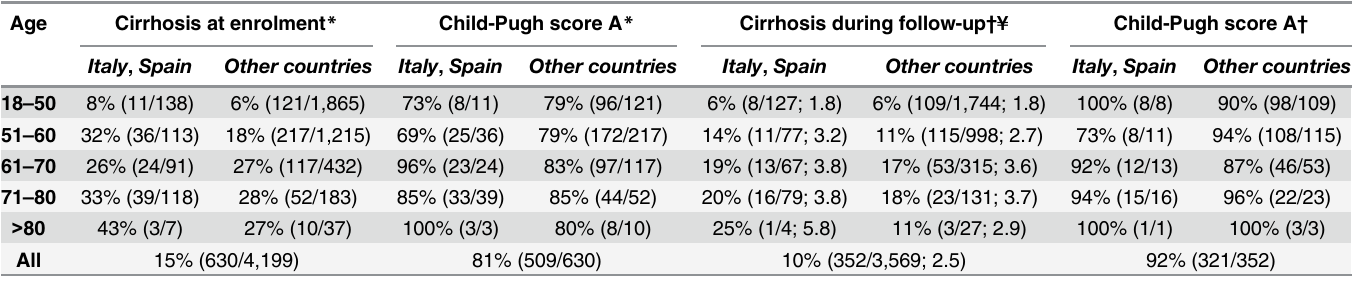
Table 4. Cirrhosis at enrolment and during follow-up in different age groups and countries of birth in the Swiss Hepatitis C Cohort Study.